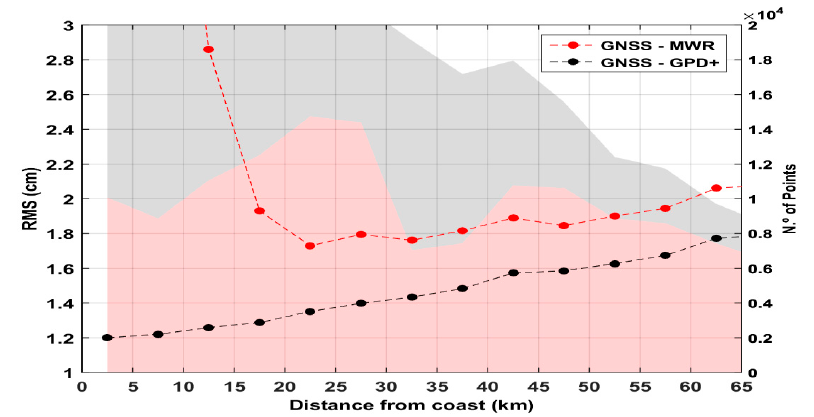
Figure 11. RMS differences between the WTC from the GNSS at coastal stations and the WTC from the S3A MWR, in cm. The grey and red coloured bars represent the number of points in each class of distance for GPD1 and the MWR, respectively.